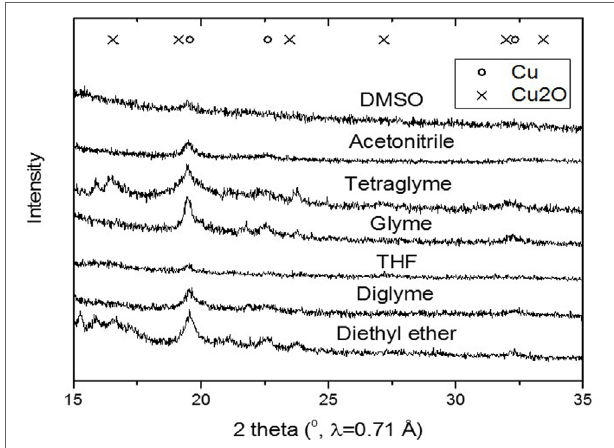
FigUre 5 | X-ray diffractogram of the slurry after low-temperature methanol synthesis reaction for the different polar